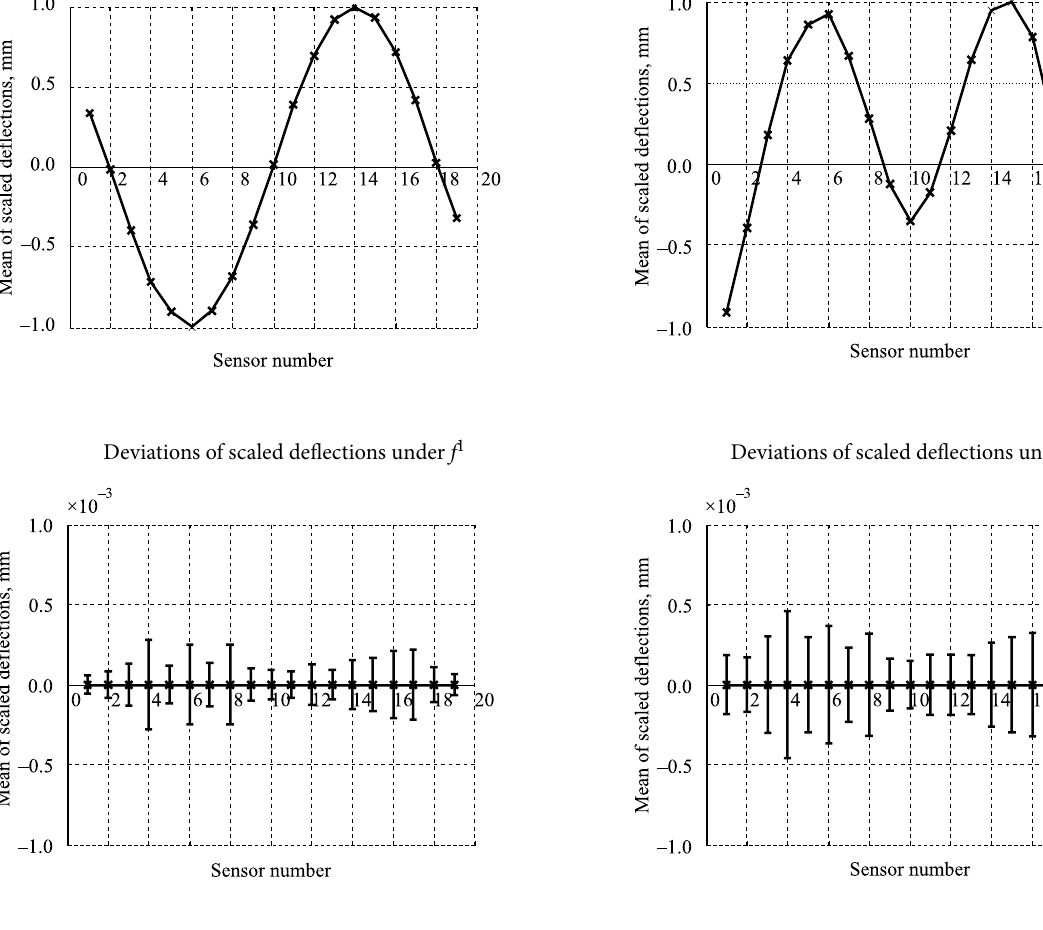
Fig. 4. Mean deflections and their deviation level under PBILs before